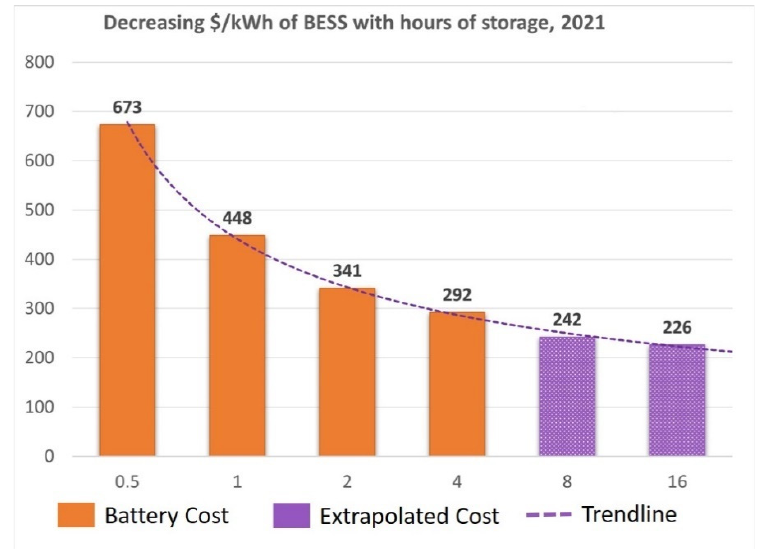
Figure A1. U.S. utility-scale Li-ion battery stand-alone storage costs for durations of 0.5–4 h (60 MW) 2018 [68]. In this figure, EPC and BOS represent Engineering and Procurement Cost and Balance of System respectively.